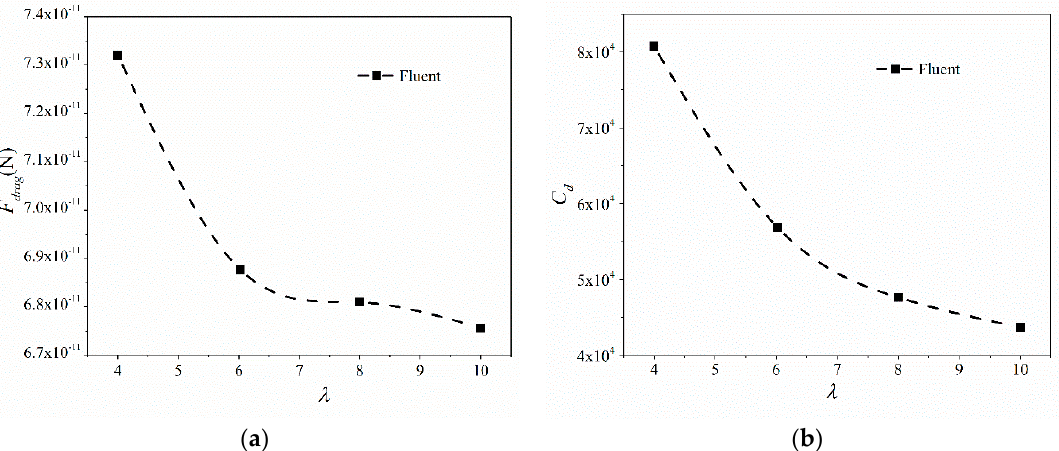
Figure 6. The drag force and drag coefficient versus the rate of length to larger radius ranging from 4 to 7.